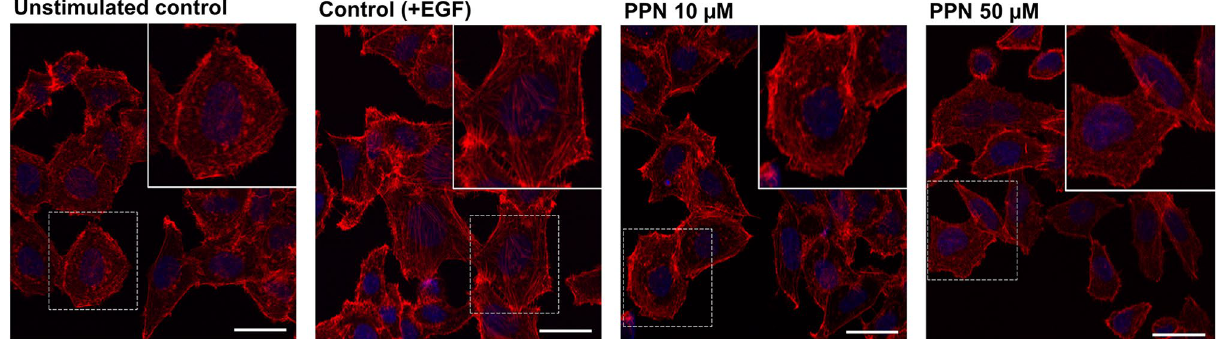
Figure 3. Propranolol modulates epidermal growth factor-induced actin cytoskeleton reorganization and stress fiber formation in osteosarcoma cells. Representative images of MG-63 cells stained with AlexaFluor555- conjugated phalloidin (red) after exposure to saline vehicle (unstimulated control), epidermal growth factor (EGF) (control), and PPN 10 or 50 µM, in addition to EGF stimulation. Nuclei were counterstained with DAPI (blue). Actin fluorescent staining in MG-63 cells grown was assessed by confocal laser scanning microscopy. Insets contain enlarged representative cells indicated by dashed squares. (×630 magnification. Scale bar = 20